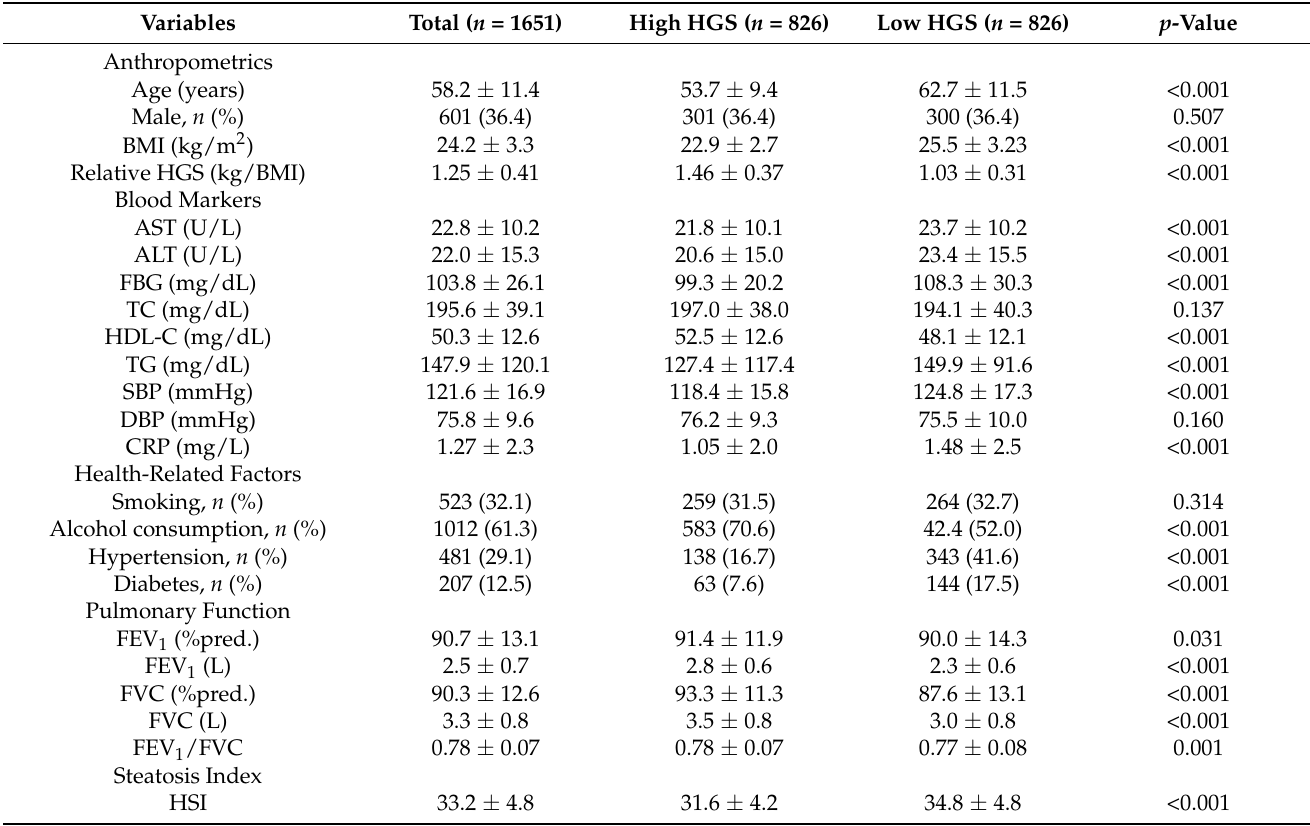
Table 2. Measured parameter values for relative hand grip